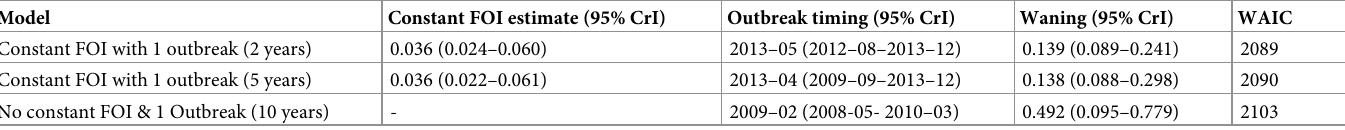
Table 3. Time-varying FOI models. Parameter estimates for the constant FOI, outbreak timing and waning for the reverse catalytic model with a constant FOI and one outbreak in the last two years, the reverse catalytic model with a constant FOI and one outbreak in the last five years, and the reverse catalytic model with no constant FOI and one outbreak in the last ten years (outbreak only